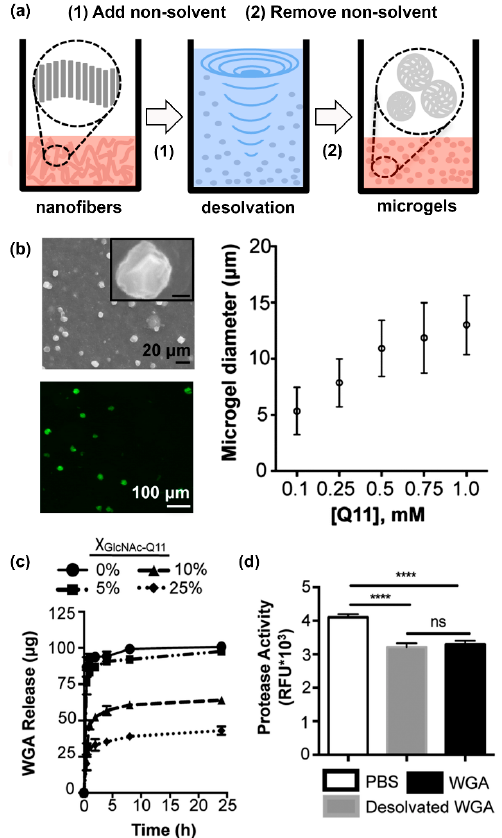
Figure 6. Lectin-releasing microgels fabricated from glycopeptide nanofibers. ( a ) Schematic representation of microgels fabricated from self-assembled peptide nanofibers via desolvation. ( b ) Microgels ranging from 5–12.5 µ m in diameter can be fabricated by adjusting peptide concentration in solution. ( c ) WGA burst release curves from microgels with different GlcNAc content: 0% (circles), 5% (squares), 10% (triangles), or 25% (diamonds). Burst release decreased with increasing amount of GlcNAc-Q11. ( d ) Jurkat apoptosis induced by WGA released from Q11 microgels (gray), or stock WGA that was not subjected to desolvation (black), demonstrating that the released proteins were active. “ns” denotes p > 0.05 between indicated groups, **** indicates p < 0.001, ANOVA with Tukey’s post hoc. Adapted from reference [100] with permission from The Royal Society of Chemistry.